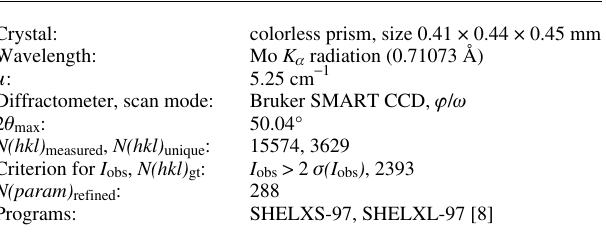
Table 1. Data collection and handling.